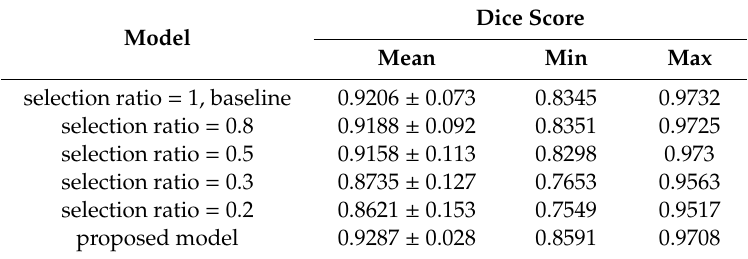
Table A4. Kidney segmentation results on test dataset based on di ff erent selection ratio using U-Net model.